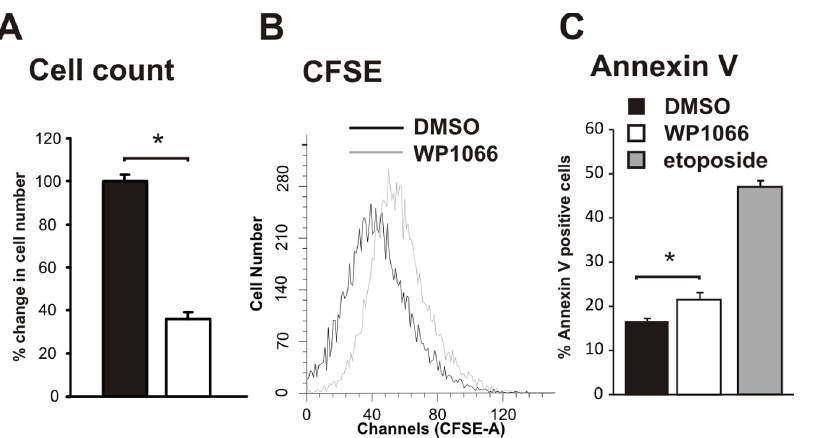
Figure 2. WP1066 inhibits proliferation and stimulates apoptosis of AGC cells. Proliferation: A. AGS cells were treated with WP1066 at 5 m M for 18 hr, stained with trypan blue and viable cells counted. Data are expressed as the percentage of viable cells compared to vehicle alone. N=3, mean 6 SE. B. CFSE tracking was used to measure changes in AGS cell proliferation after treatment with WP 1066. The raw fluorescence data collected is shown compared to DMSO controls for a representative experiment. Apoptosis: C. AGS cells treated for 24 hr with DMSO (method control), WP1066 (5 m M) or etoposide (200 m M; positive control) and adherent cells were stained with Annexin V then counted manually. Data are expressed as fold change compared to DMSO vehicle from a representative experiment.